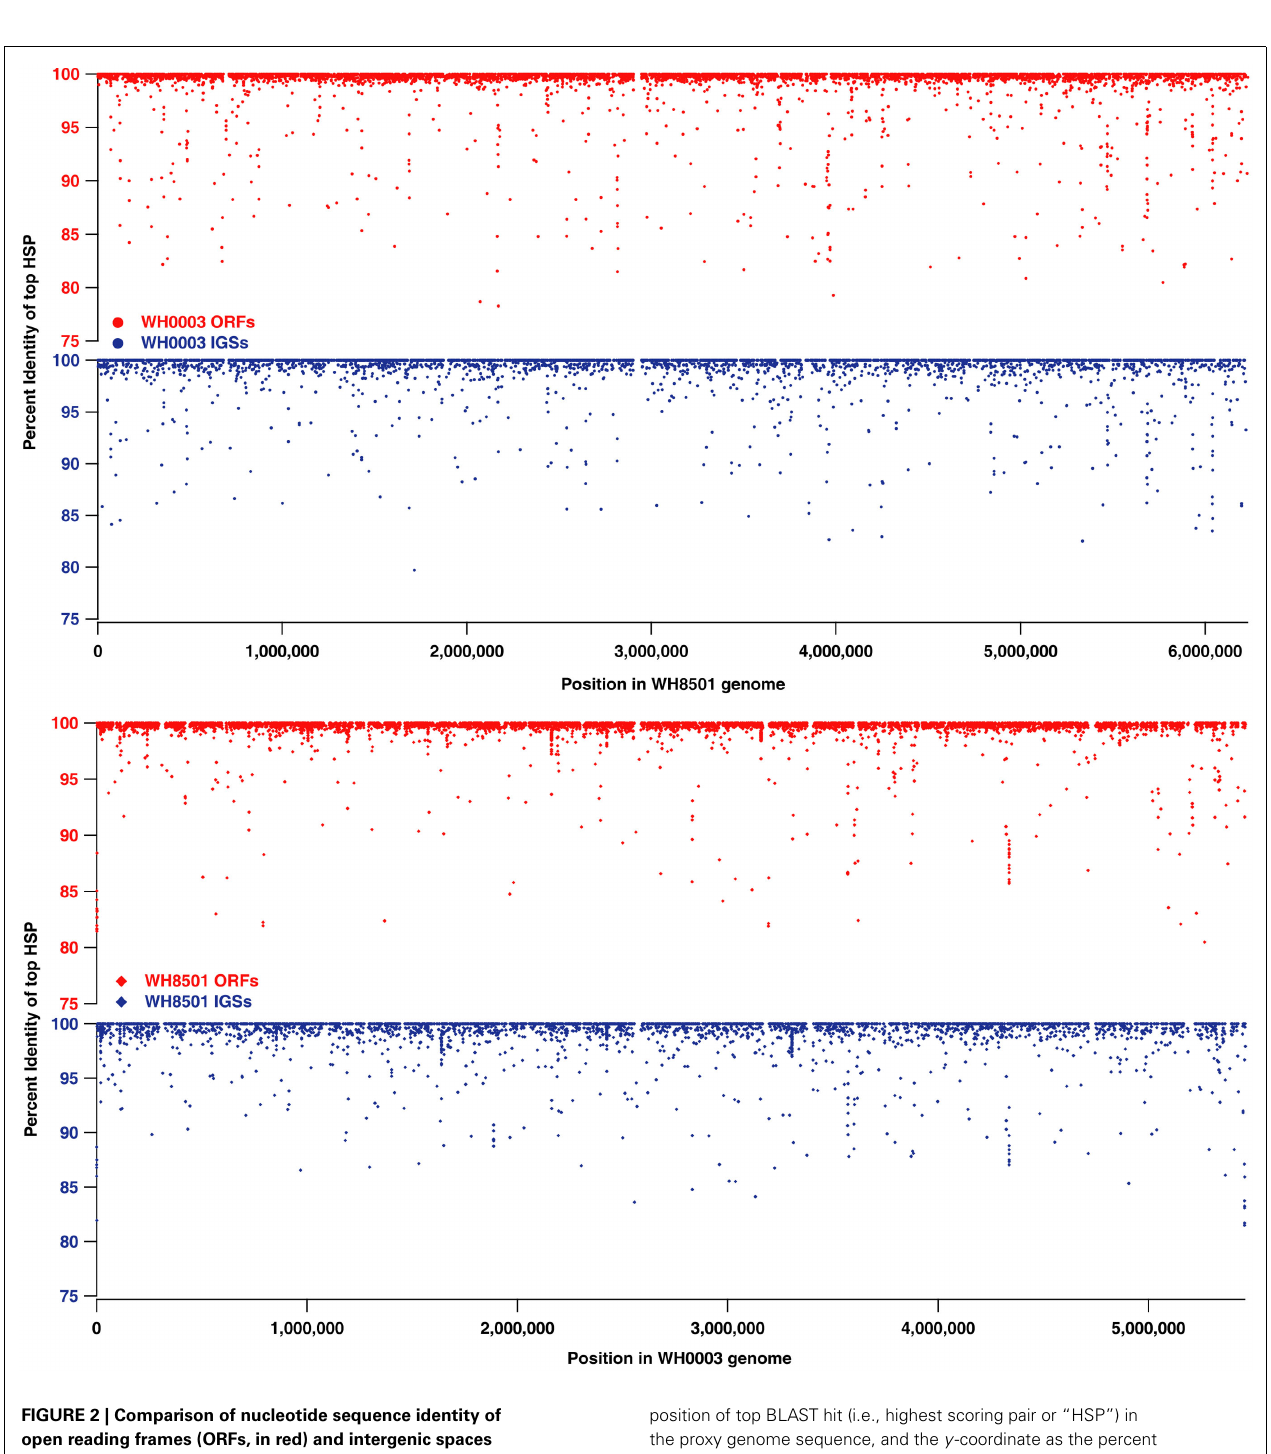
position of top BLAST hit (i.e., highest scoring pair or “HSP”) in the proxy genome sequence, and the y -coordinate as the percent identity of the top BLAST alignment when compared to the alternate strain